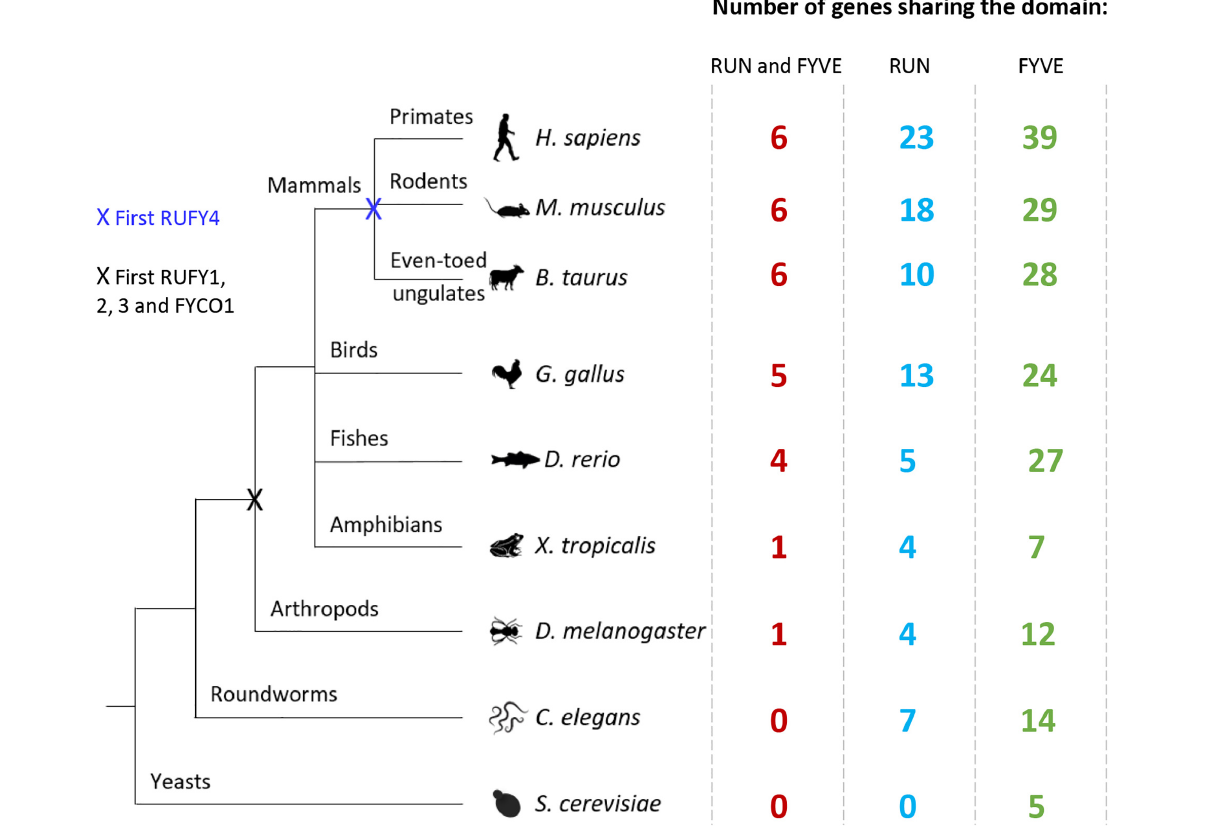
Frontiers in Cell and Developmental Biology |